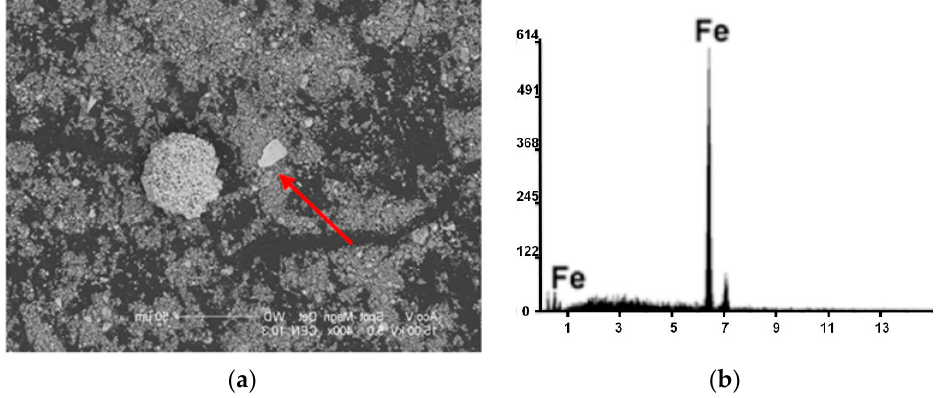
Figure 7. Metallic iron particle (indicated with red arrow) in iron-bearing sludge dust (sample No. 22): ( a ) SEM image; ( b ) the EDS spectrum. ( a ) SEM image; ( b ) the EDS Figure 6. XRD pattern of sample No. 22 and 23. Symbol explanation: C — calcite, H — hematite, I — iron, M — magnetite, S — srebrodolskite.